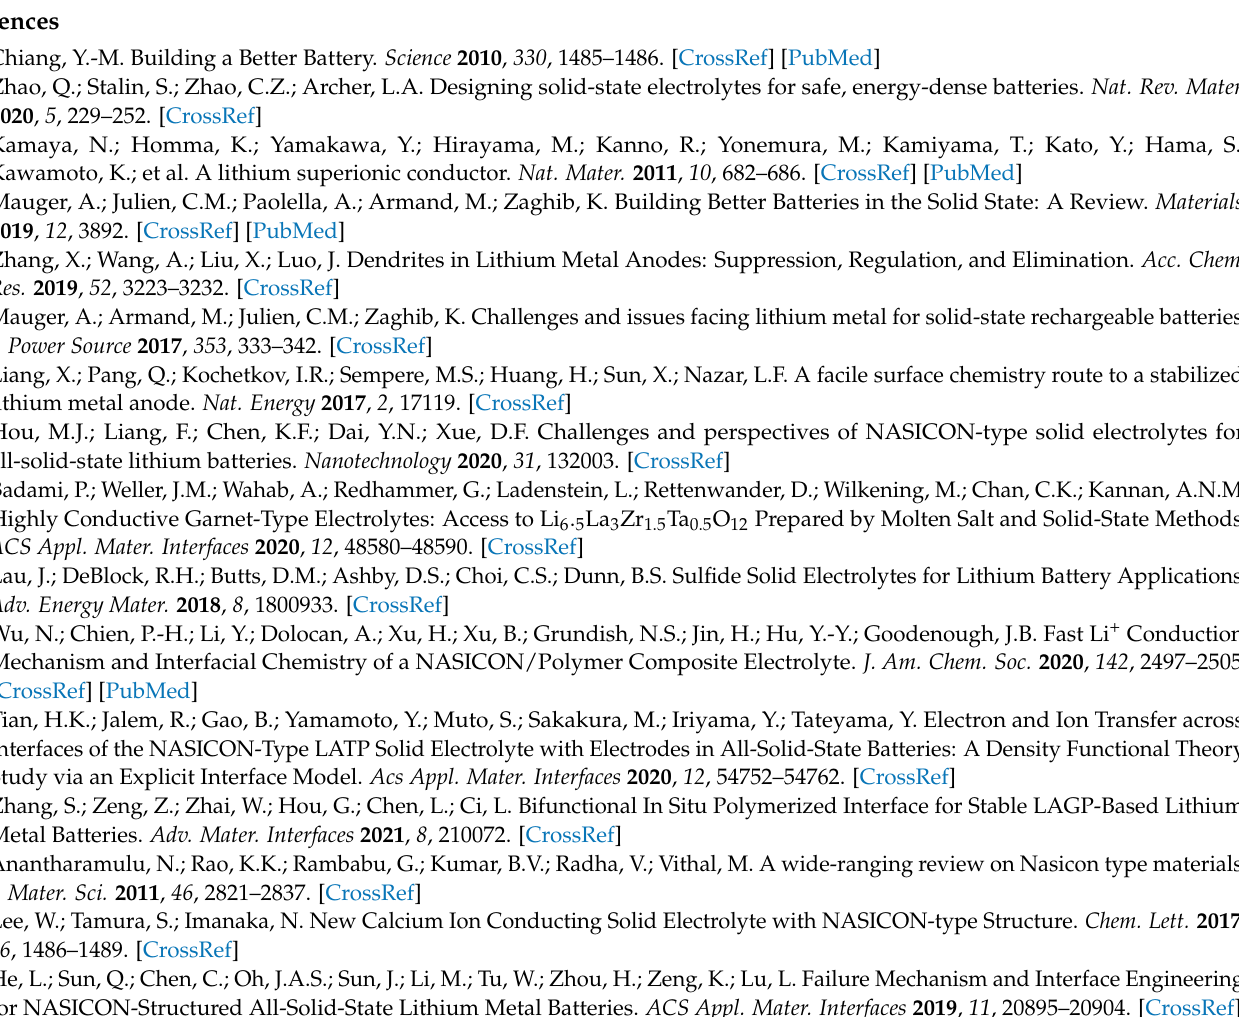
LAGP pellet; Figure S2: Polarization curves of the LAGP and CuS@LAGP pellet and inset are the impedance spectras of the Li symmetric cell before and after polarization, respectively; Figure S3: Impedance spectra of CuS@LAGP/Li symmetric cells with various sputtering times; Figure S4: AFM images of the CuS membrane at the edge region of different sputtering times and its corresponding height profiles; Figure S5: Top-view SEM image of fresh lithium foil; Figure S6: The high-resolution mapping of Cu and S elements on post-cycle LAGP pellets; Figure S7: Ge 3d XPS spectrum of the post-cycled bare LAGP pellet and CuS@LAGP pellet; Table S1. Average sputtering rate test data of the CuS target under the condition of 80W of power at room